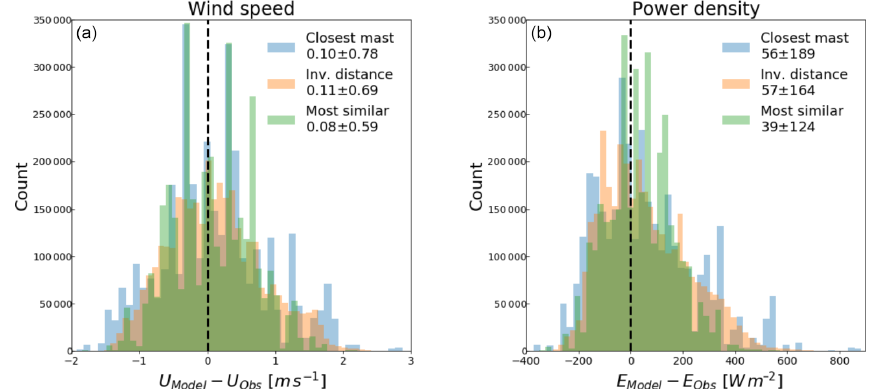
Figure 5. Histograms of the absolute wind speed (a) and power density (b) error for different combinations of prediction location and six predictor masts using the three different multi-mast strategies. Each histogram consists of more than 33 million